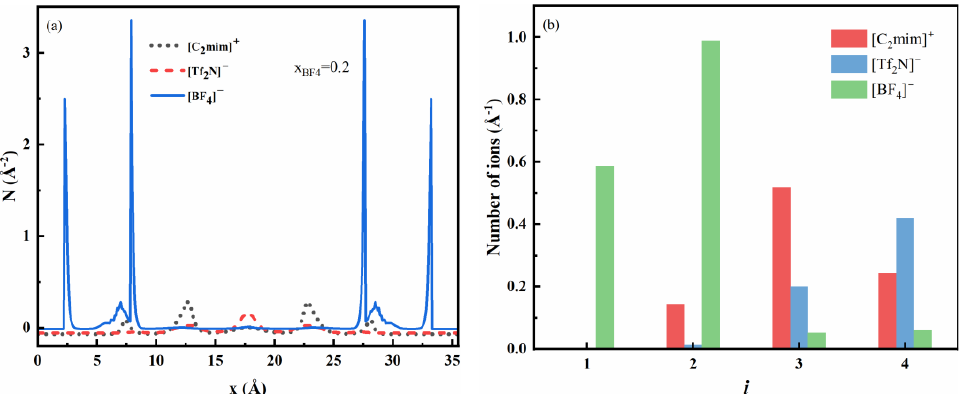
Figure 5. ( a ) Local excess adsorption of ions in nanopore with rough surfaces. ( b ) Number of ions adsorbed in the four layers near the surface ( i = 1 is the first layer, i = 2 is the second layer, i = 3 is the third layer, i = 4 is the fourth layer). Other conditions are the same as in Figure 3.